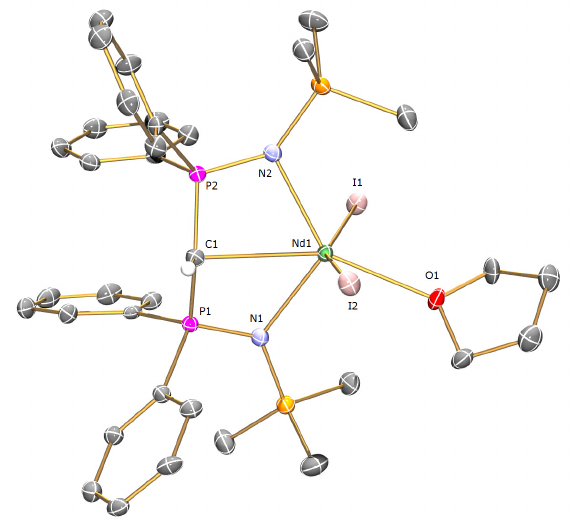
Figure 1. Molecular structure of 1a C ellipsoids are drawn at 50% probability, with lattice solvent and non-methanide hydrogen atoms omitted for